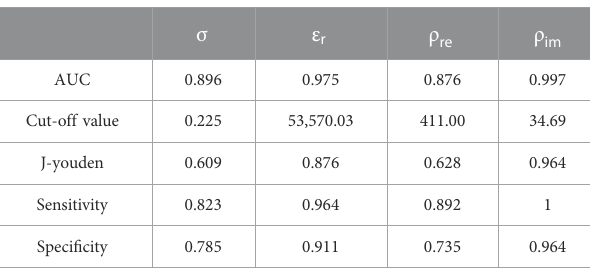
TABLE 2 Area under the receiver operator characteristic curves for ability to predict RCC for dielectric